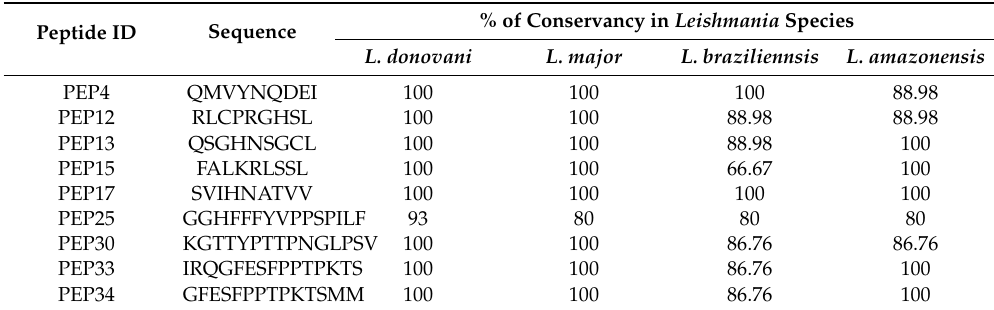
Table 1. Conservancy analyses among various Leishmania species of the eight epitopes selected to compose peptide-based vaccines, using the IEDB conservancy